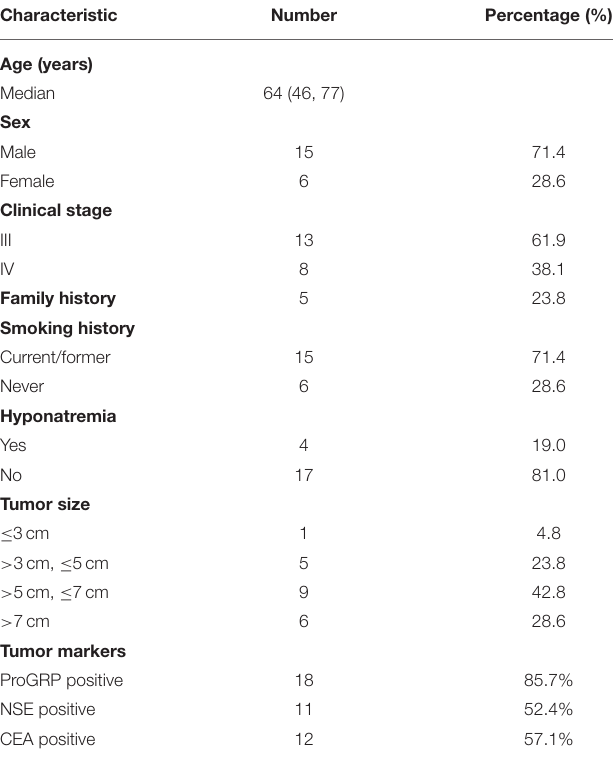
TABLE 1 | Patient